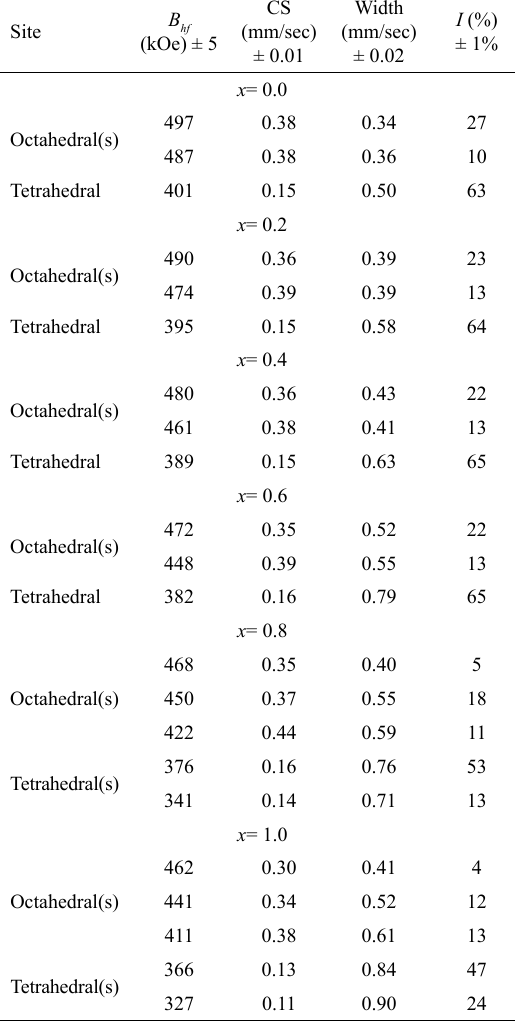
Table 3. The hyperfine parameters and the percentage relative intensities ( I ) obtained at room temperature for Y garnet